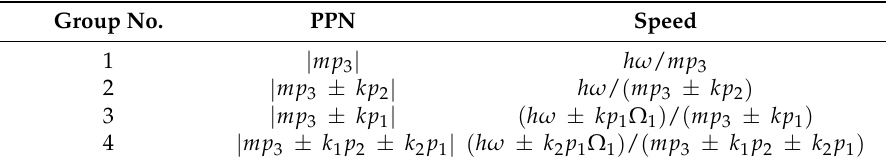
Table 3. Field harmonics excited by the armature windings. Group